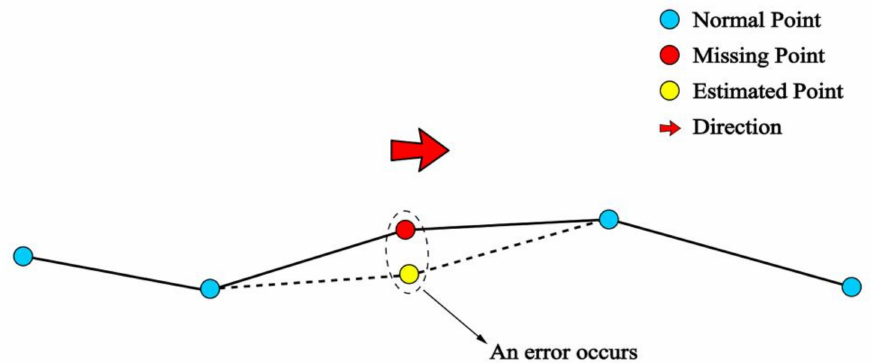
Figure 2. Kinematic